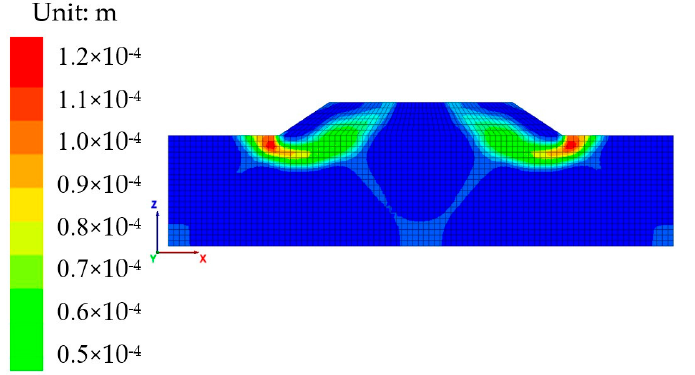
Figure 7. Shear strain increment contour of the model without ELB.